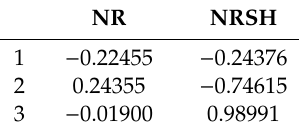
Table 2. Calculated variation of electron population number of each fragment of NR and NRSH .